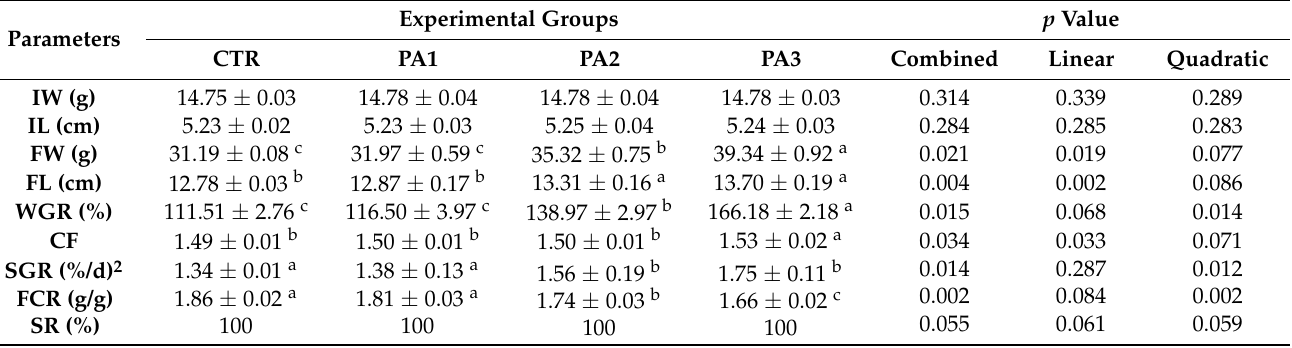
Table 4. The effects of P. australis extract (0, 100, 200, and 400 mg extract/kg diet) dietary administra- tion on growth performance and feed efficiency of common carp for 56 days ( n = 3).